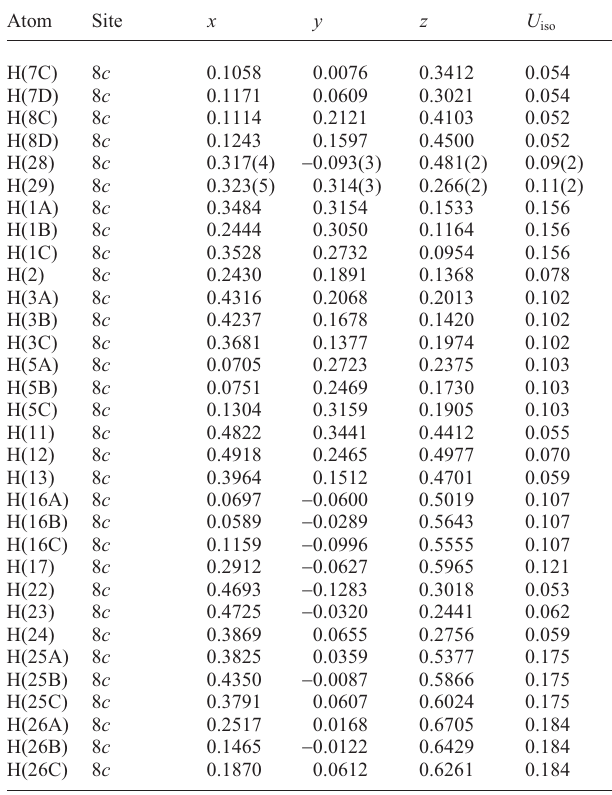
Table 2. Atomic coordinates and displacement parameters (in Å 2 )